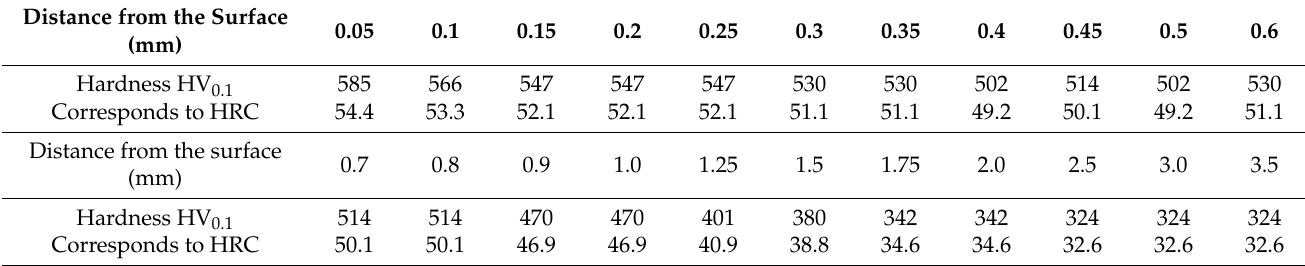
Table 10. Microhardness of the inactive tooth flank of the tooth hard-faced with the EVB2CrMo FM. Distance from the Surface (mm) Hardness HV 0.1 Corresponds to HRC Distance from the surface 0.7 (mm) Hardness HV 0.1 Corresponds to HRC 50.1